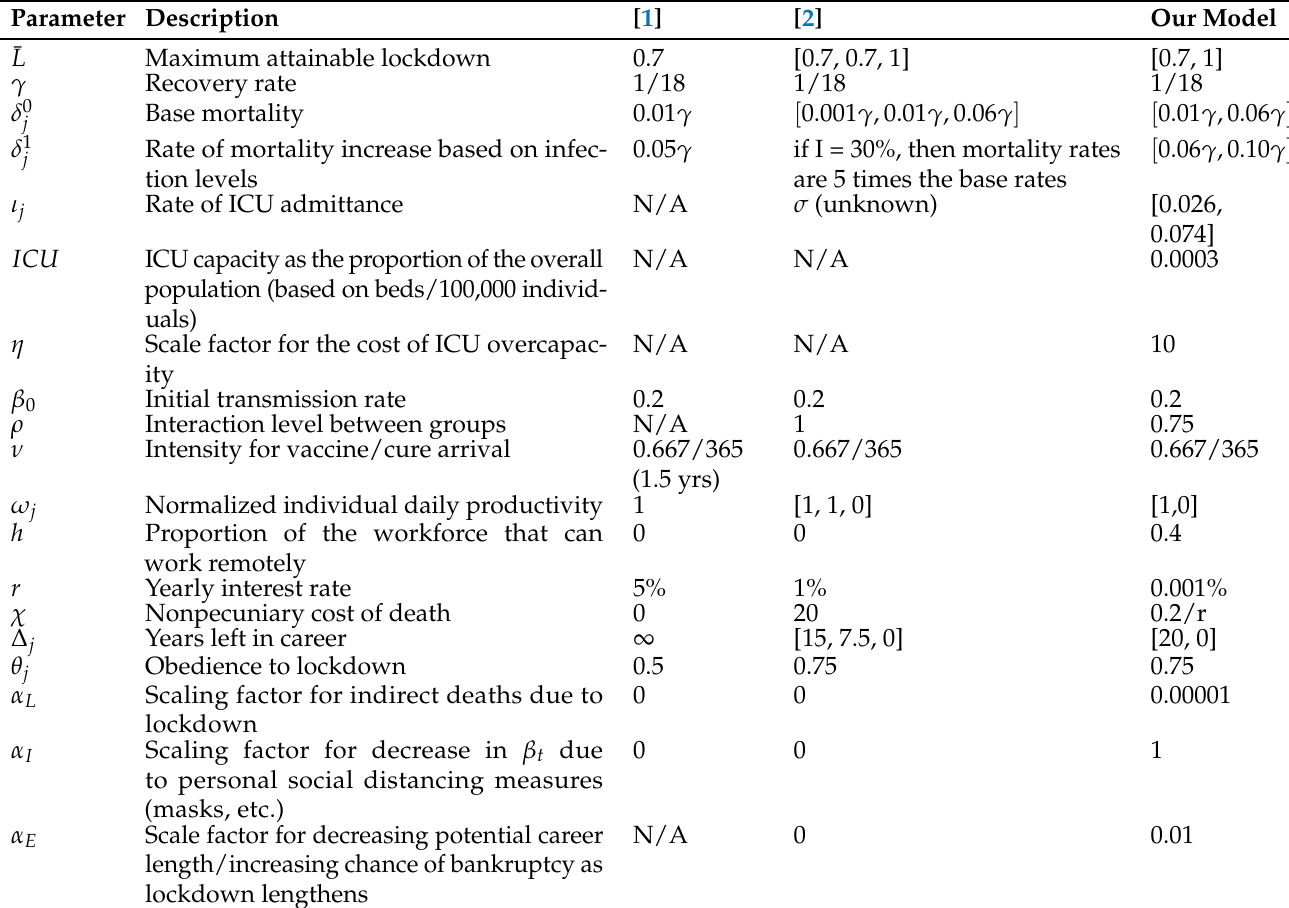
Table A1. Full list of